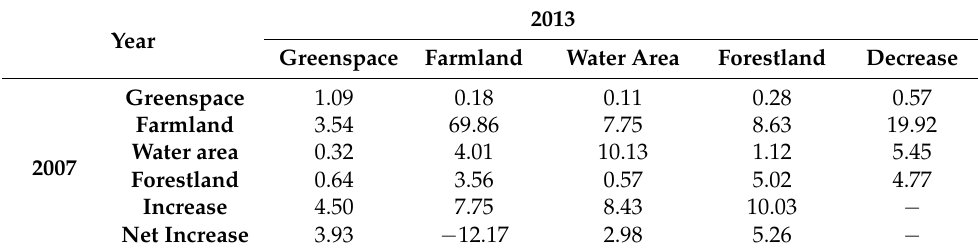
Table 4. GI transformation area (km 2 ) matrix from 2007 to 2013.